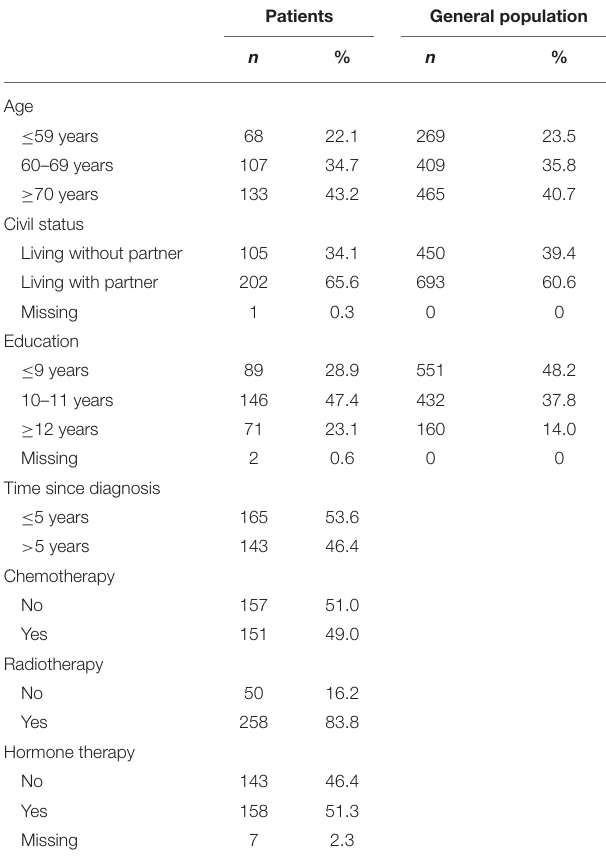
TABLE 1 | Sociodemographic characteristics of the sample of cancer patients ( n = 308) and the general population sample ( n =